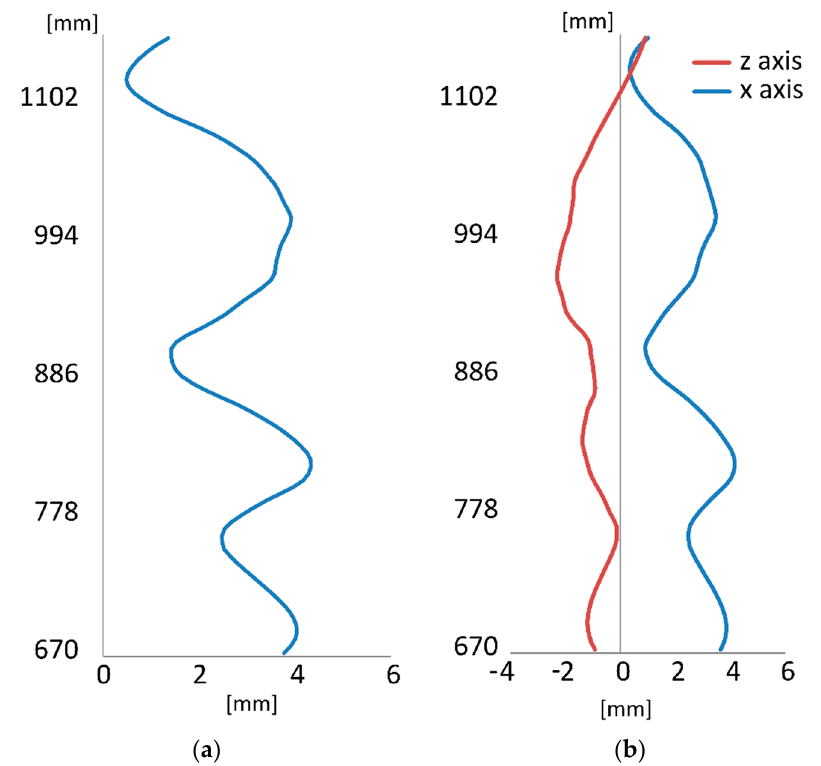
Figure 7. Distribution of differences in distances between points belonging to the reference and subject spinous processes lines ( a ) and the x - and z -axes ( b ). The ordinate and abscissa values are presented using different scales to visualize the abscissa axis data better.